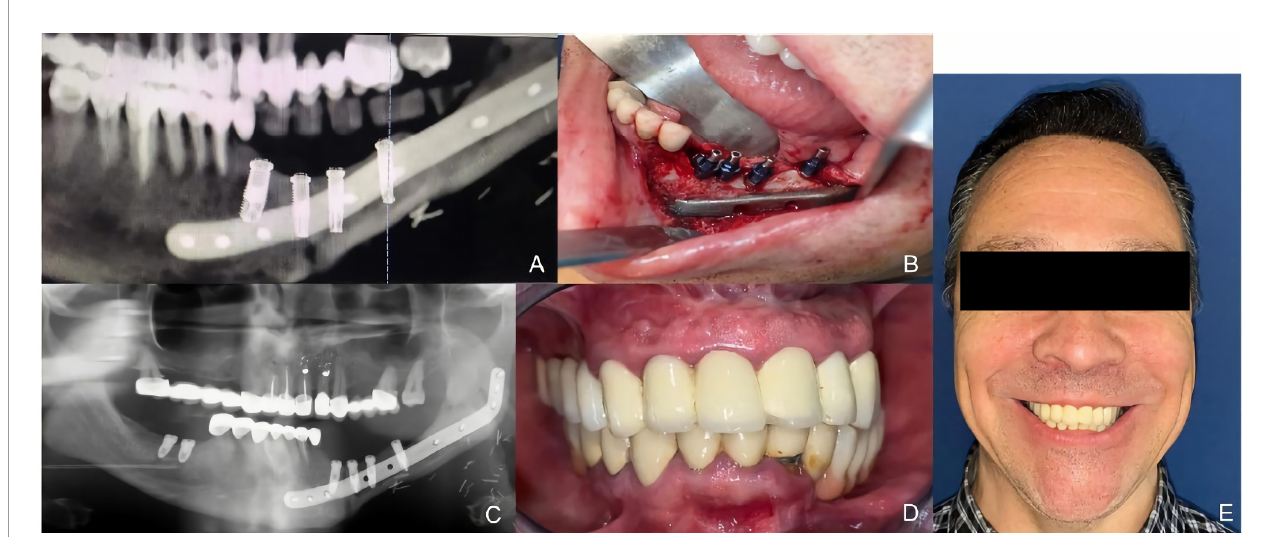
FIGURE 11 | (A) Virtual planning of dental implants. (B) Intraoperative implant placement through dynamic navigation. (C) Panoramic radiograph after surgery showing a high accuracy compared with the virtual planning. (D) Prosthetic rehabilitation with implant fi xed prosthesis. (E) Aesthetic and functional